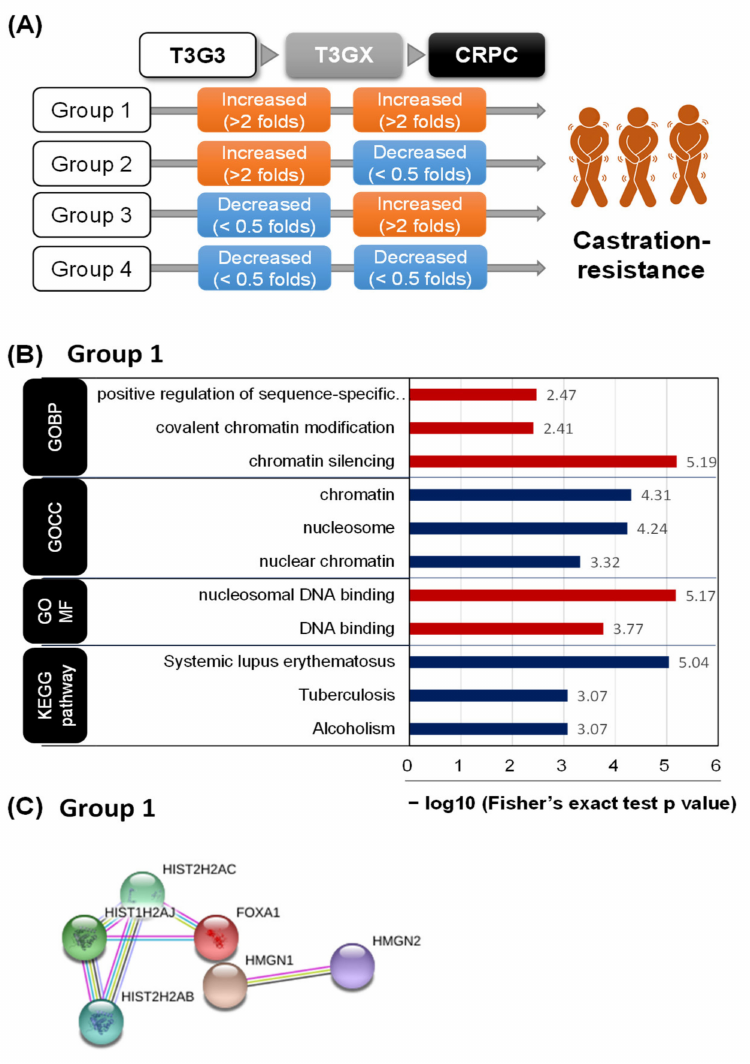
Figure 3. The expression of differential proteins based on cluster analysis among prostate cancer (PCa) stages. ( A ) Summary of cluster groups of differential proteins for visual exploration according to PCa stages. ( B ) Enriched gene ontology (GO) and Kyoto Encyclopedia of Genes and Genomes term: Group 1 represents increased proteins in both the T3GX/T3G3 and the CRPC/T3GX groups. The numbers of each bar reflect the proportion of differentially expressed proteins for every GO annotation. ( C ) STRING protein network for Group 1. CRPC, castration-resistant PCa; T3GX, patients with androgen deprivation therapy-treated T3G3